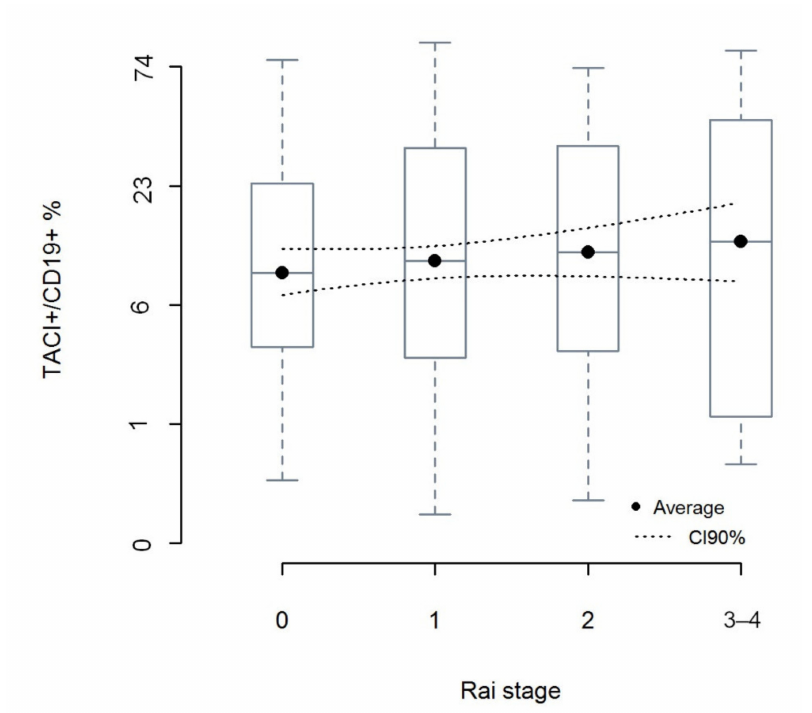
Figure 2. The percentage of CD19 + TACI + leukemic cells in groups of CLL patients according to the Rai stage. Box-and-whisker plots in standard manner with expected value as central points, 1st and 3rd quartiles and min-max values. Di ff erence between groups tested with ANOVA with linear contrasts. Although in case of a patient there can be 0,1,2,3 or 4 Rai stage score, but in case of any group of patients there is always a mean of such stages, which can take any value between 0 and 4. Dot lines bounds 90% confidence interval for the mean of CD19 + TACI + % in a group of patients with particular mean of Rai stage. For ANOVA table and additional information please see Supplementary Table